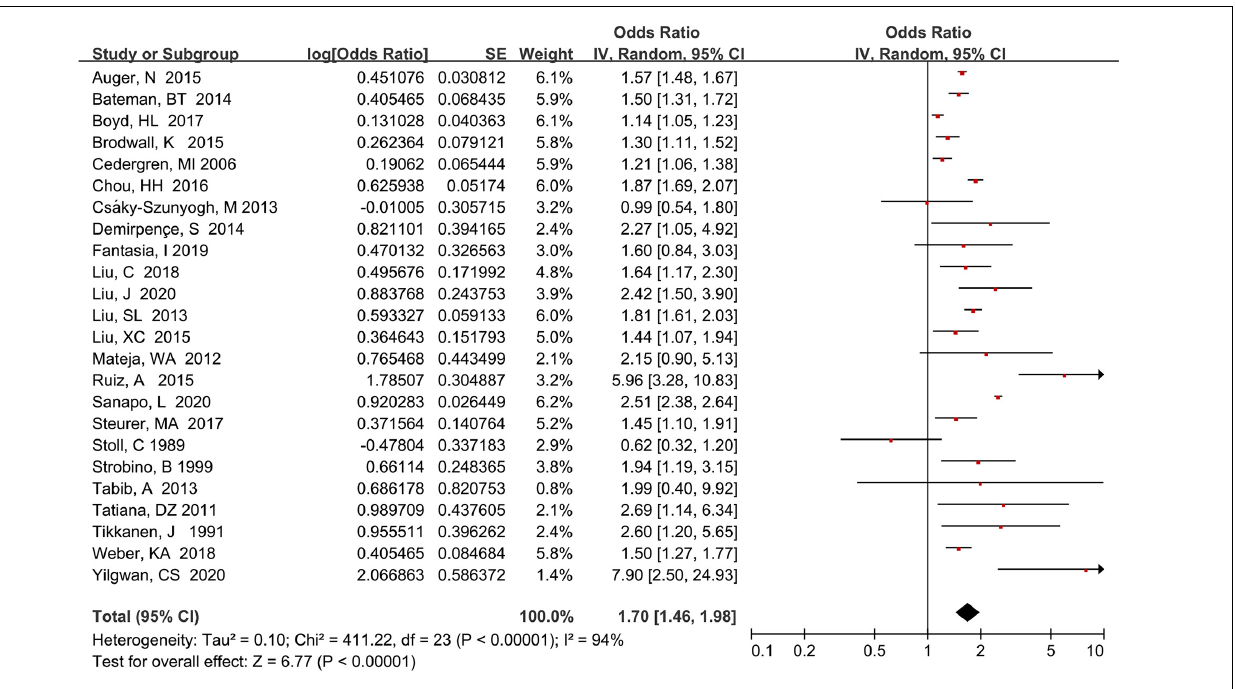
FIGURE 2 | Forest plot of maternal HDP exposure and risk of total CHDs in